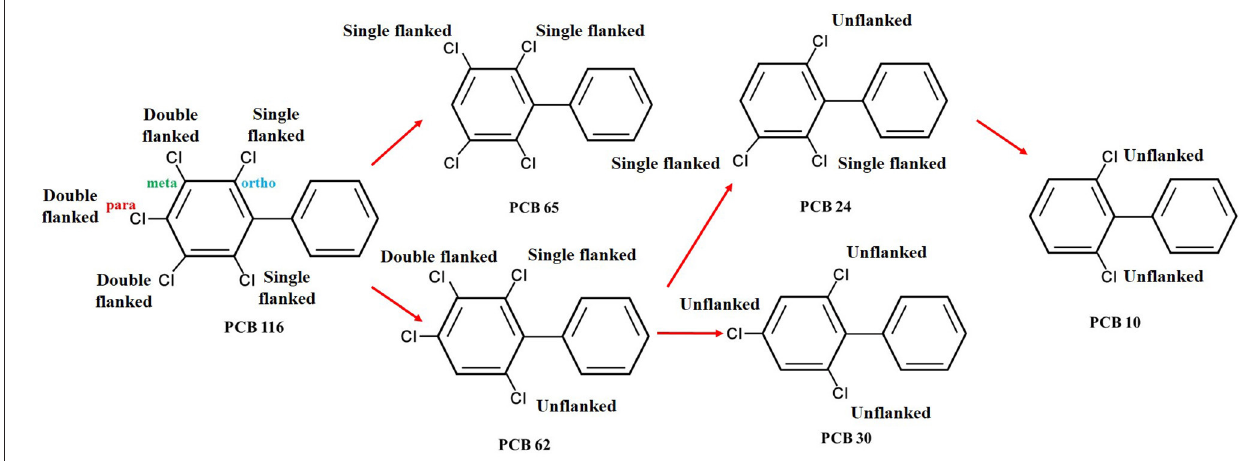
FIGURE 1 | Possible dechlorination pathway of 2,3,4,5,6-Pentachlorobiphenyl and the distribution of products (Freely after Van Dort et al.,